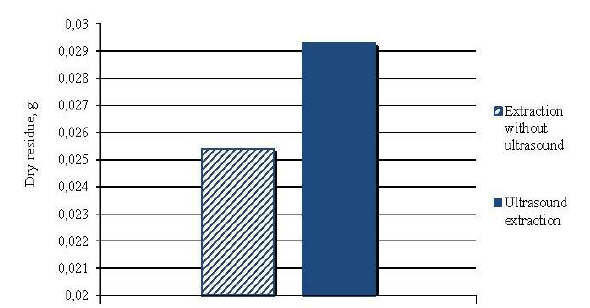
Fig. 9. Effect of polysorbate-80 on the amount of dry